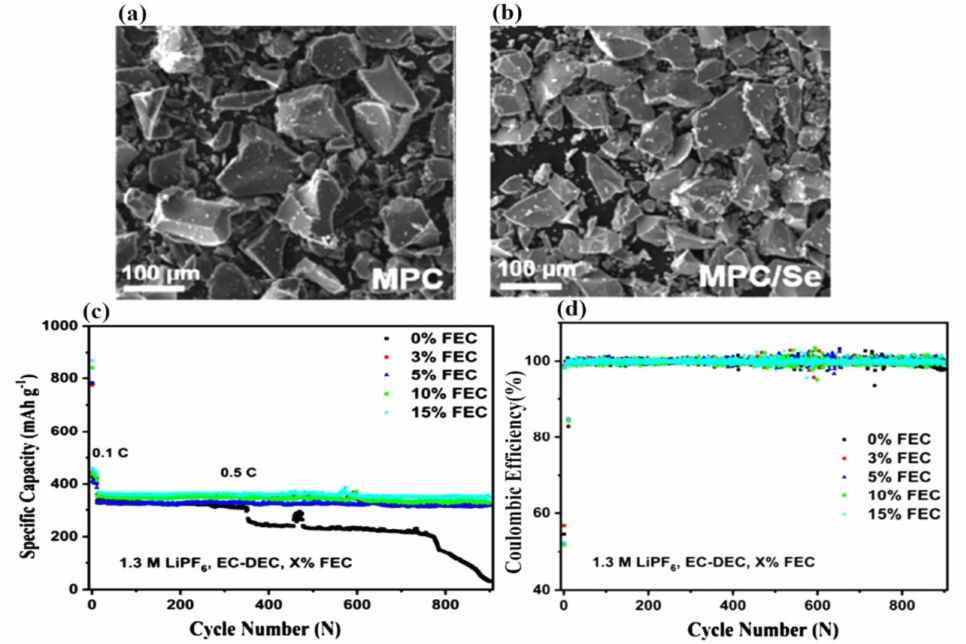
Figure 5. SEM image of ( a ) MPC and ( b ) MPC/Se. ( c ) Cycling performance and ( d ) coulombic efficiency of MPC/Se cathode in a half-cell configuration with 1.3 M LiPF6, EC:DEC electrolyte with 0–15% FEC additive. The testing was performed at 0.1 C in the first 10 cycles and 0.5 C afterward (1 C = 678 mA g − 1 ). Reproduced with permission from [46], Copyright 2020, IOP